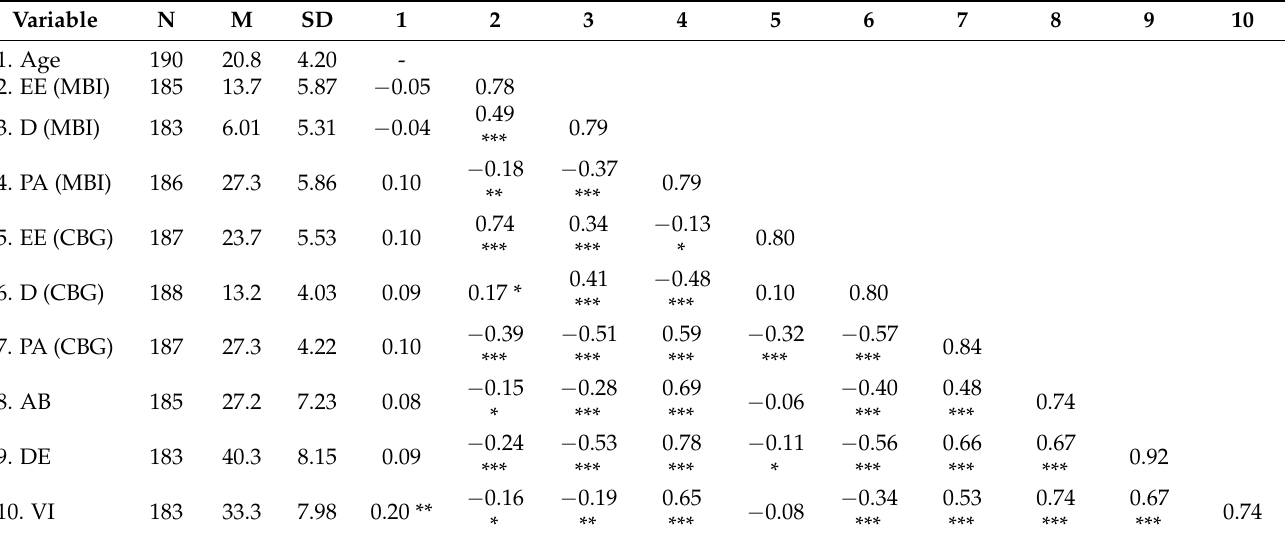
Table 1. Descriptive statistics and correlations for continuous variables in the first